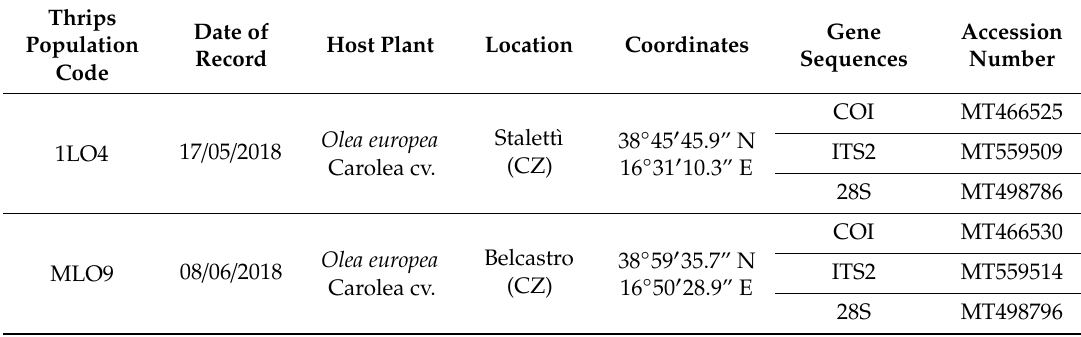
Table 2. Information about Liothrips oleae and the accession numbers related to the gene sequences of the samples